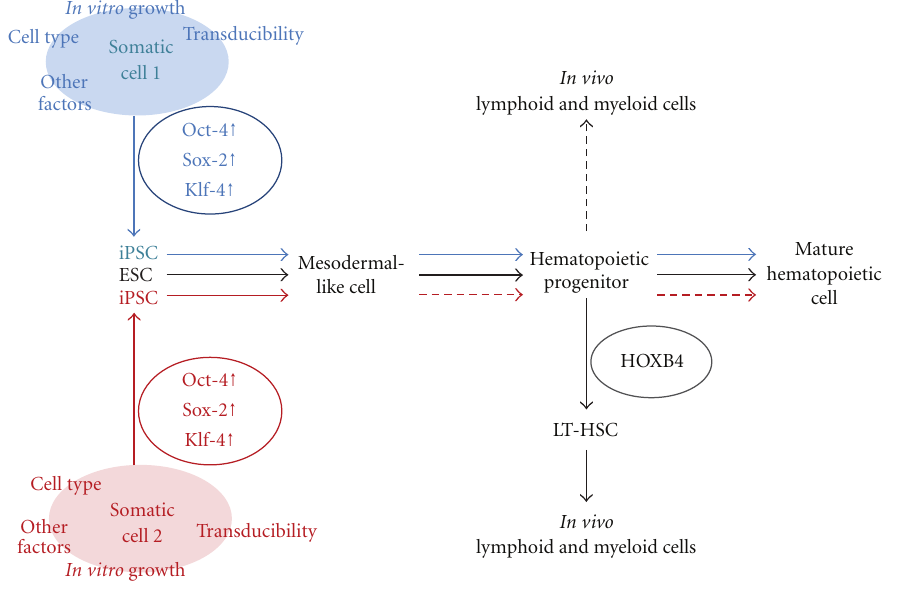
Figure 1: Overview of the current understanding of the e ffi ciency to induce iPSC from di ff erent types of somatic cells, and subsequent development of iPSC into hematopoietic cells. Dashed lines implicate lower numbers of cells developing from the former cell type compared to full